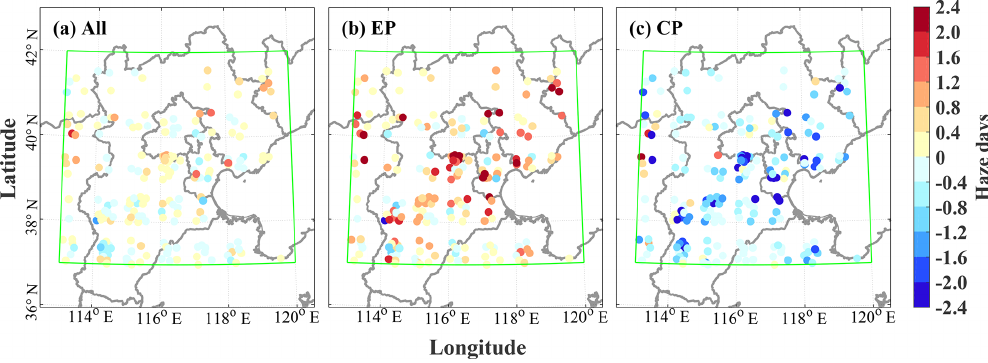
Figure 2. Composite changes in winter haze days at all sites over the JJJ region in (a) all El Niño, (b) EP El Niño, and (c) CP El Niño years relative to the 1961–2013 mean winter haze days (unit: day). The green box represents the domain of the JJJ region (37–42 ◦ N, 113–120 ◦ E) in this study.